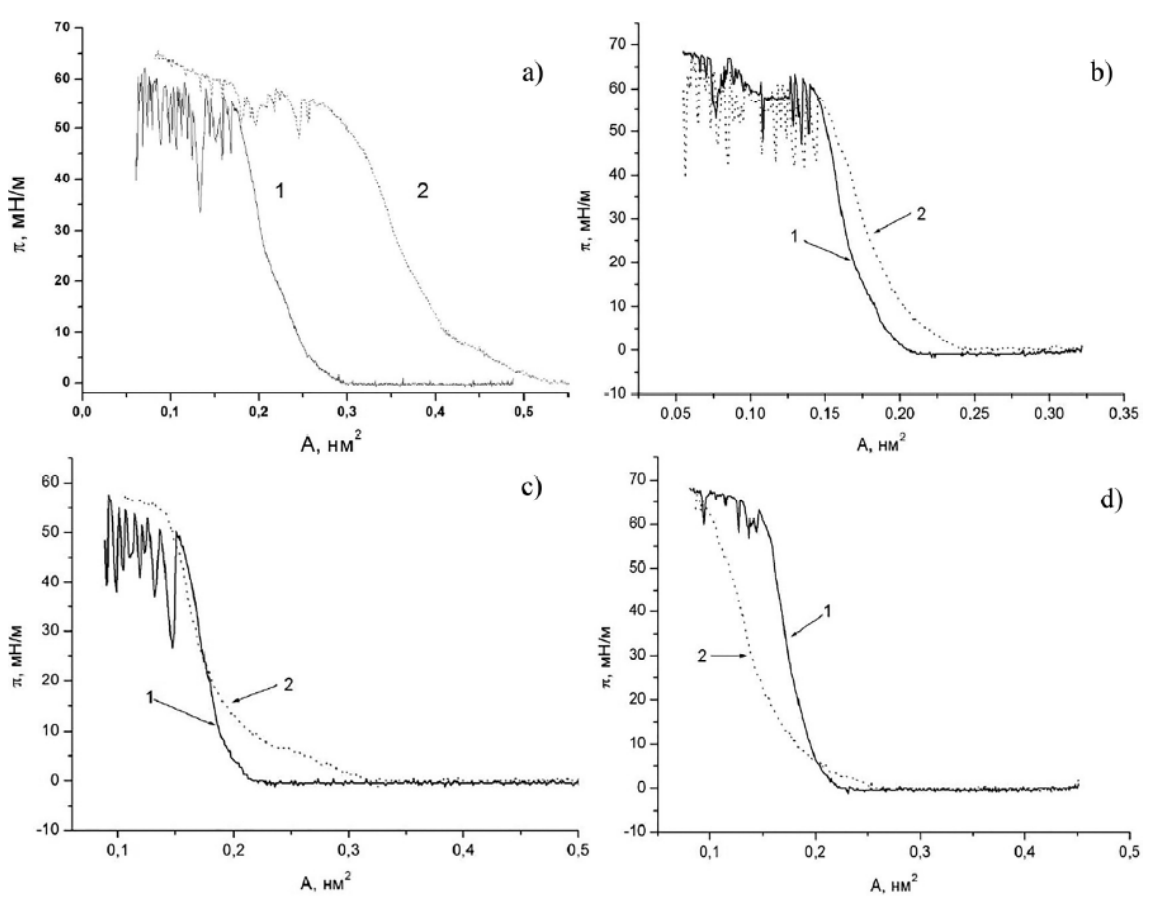
Fig. 5. The compression isotherms of the ODA monolayer on water (1) and the ODA monolayer containing iron - a), nickel - b), cobalt - c) and copper - d) HCF nanoparticles (2).